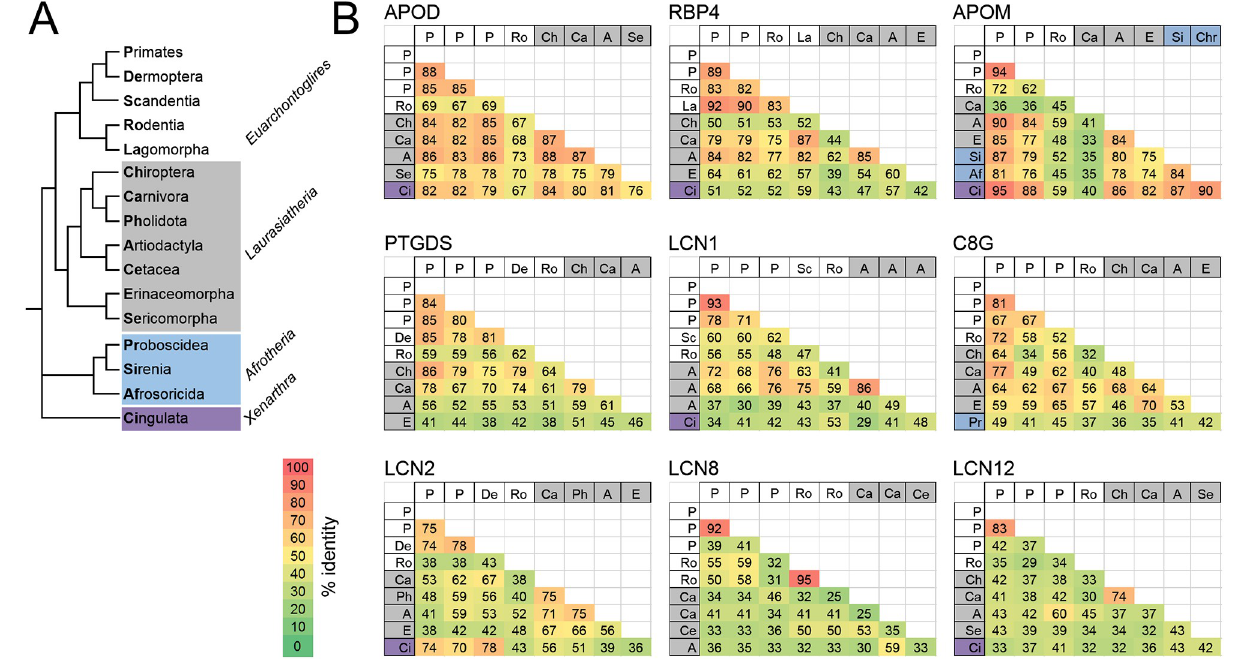
Fig 5. Distance matrix analysis of Lipocalin 5’ UTRs along mammalian evolution. (A) Cladogram of the set of 16 mammalian orders, belonging to three Eutherian taxonomic ranks, used for the comparison of RefSeq 5’ UTRs of Lipocalins. Color code is used in A and B to indicate evolutionary depth. (B) Distance matrices obtained from multiple sequence alignments (MSA) are shown color-coded. Number represent sequence similarity (% identity) in different mammalian orders of the RefSeq 5’ UTRs of nine out of the eleven Lipocalins studied in this work. Missing sequences of OBP2A and ORM2 in several orders precluded an analysis with sufficient evolutionary depth for these Lipocalins.